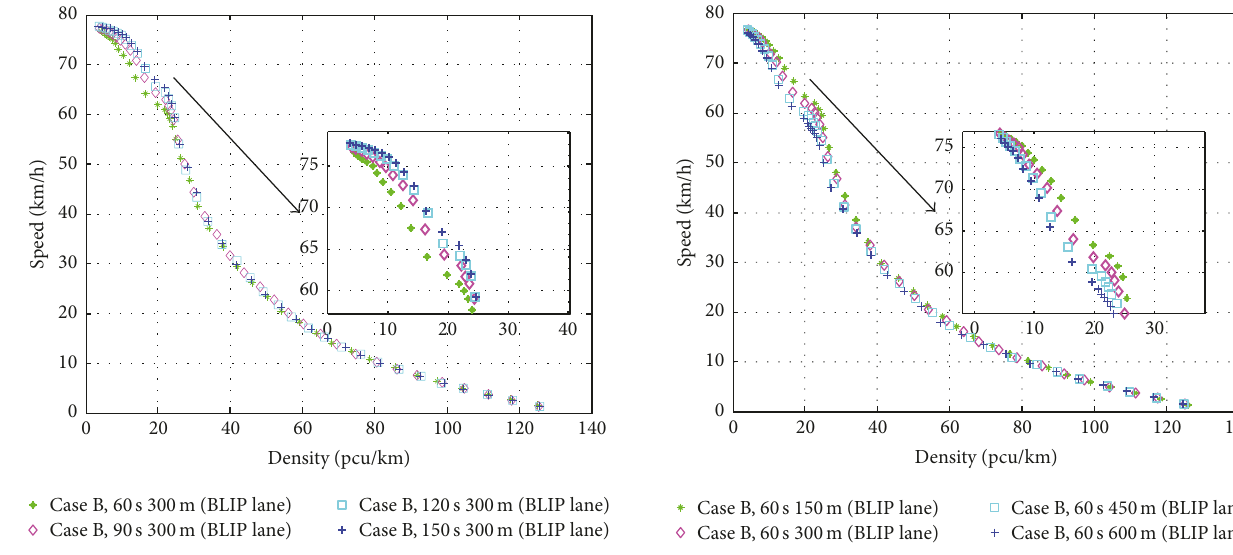
Figure 8: Speed-density relationship under various bus departure interval factors.